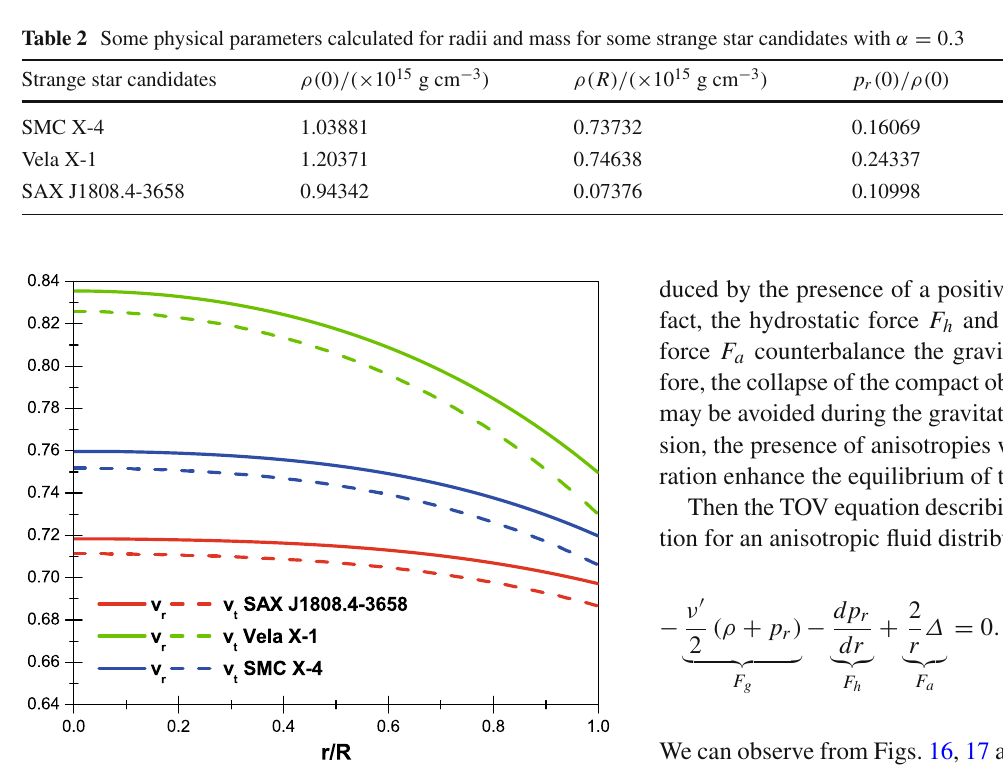
Fig. 11 Sound speeds against the dimensionless radius for α = 0 . 3